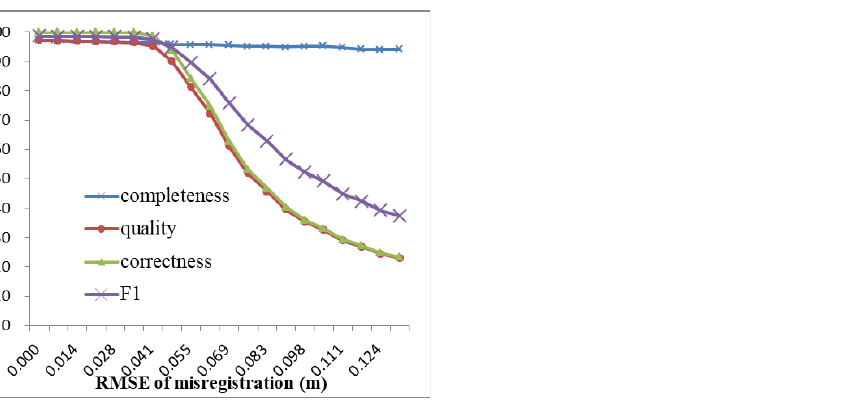
Figure 4. Results of experiment 1 (the results of 3D change detection varying the registration error through the approach using adaptive thresholds). Table 1. The accuracy of 3D change detection with different registration errors through the approach using adaptive thresholds.